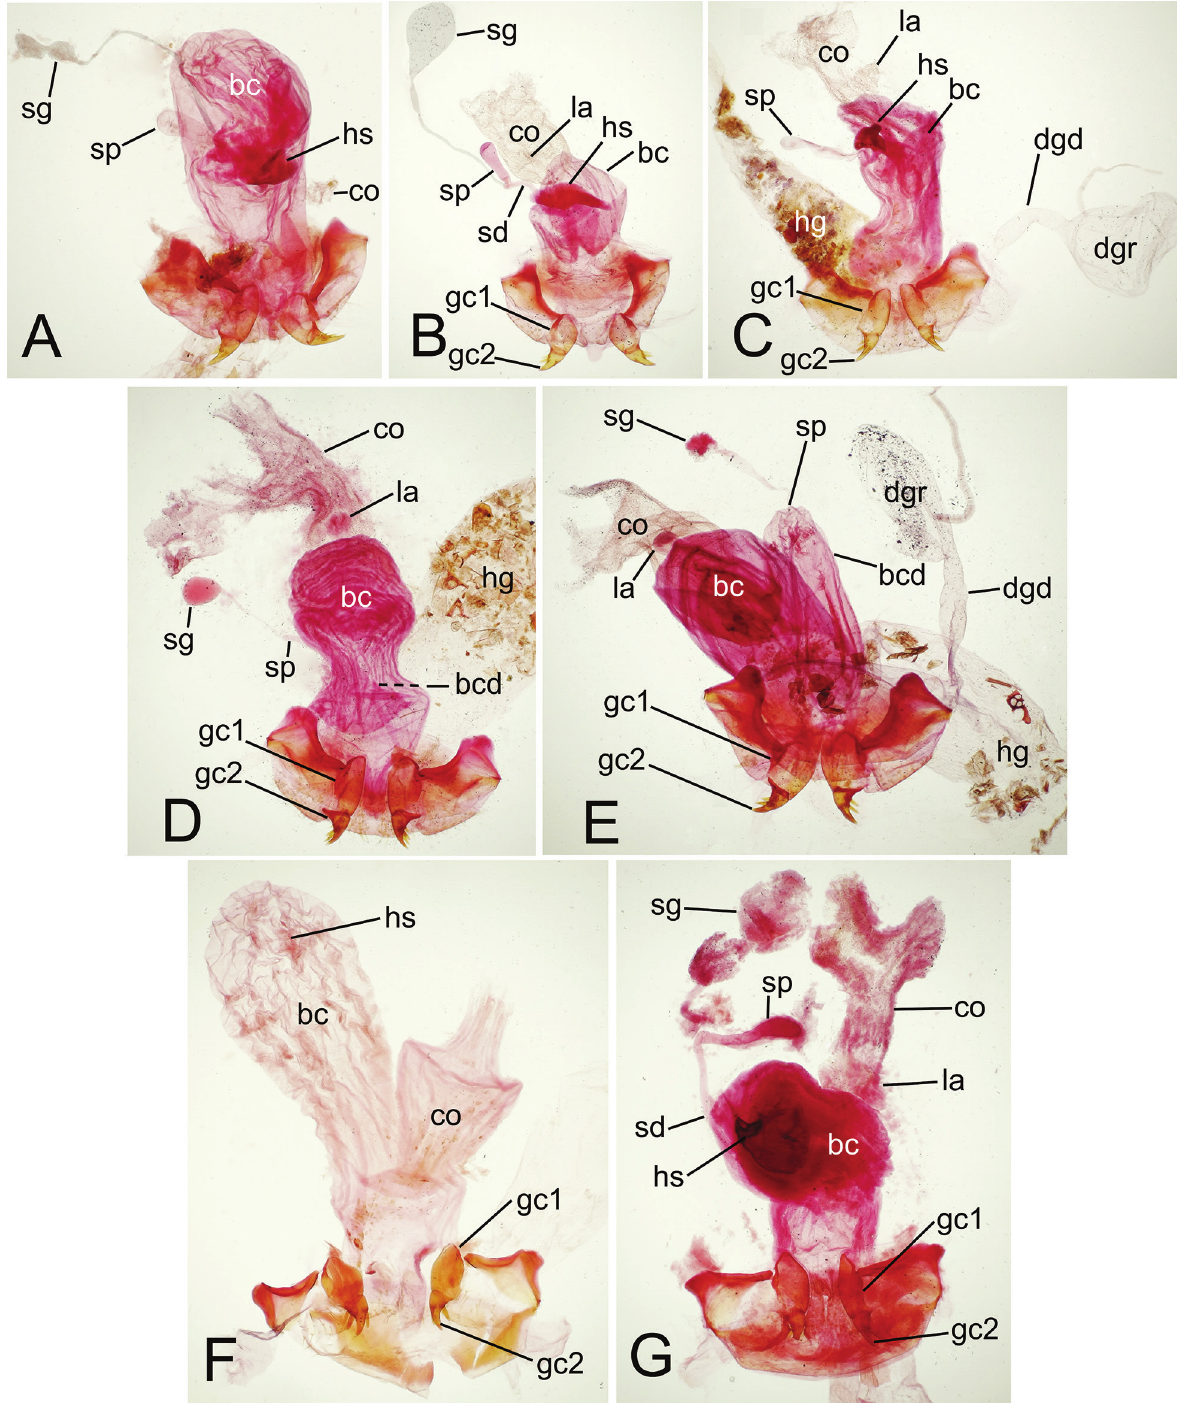
Figure 12. Female reproductive tract, gonocoxites and associated laterotergites, Mecyclothorax ( Phacothorax ) spp: A , M. latero- bustus ; B , M. laterosinuatus ; C , M. laterorectus ; D , M. fleutiauxi ; E , M. jeanneli ; F , M. plurisetosus ; G , M. megalovatulus .